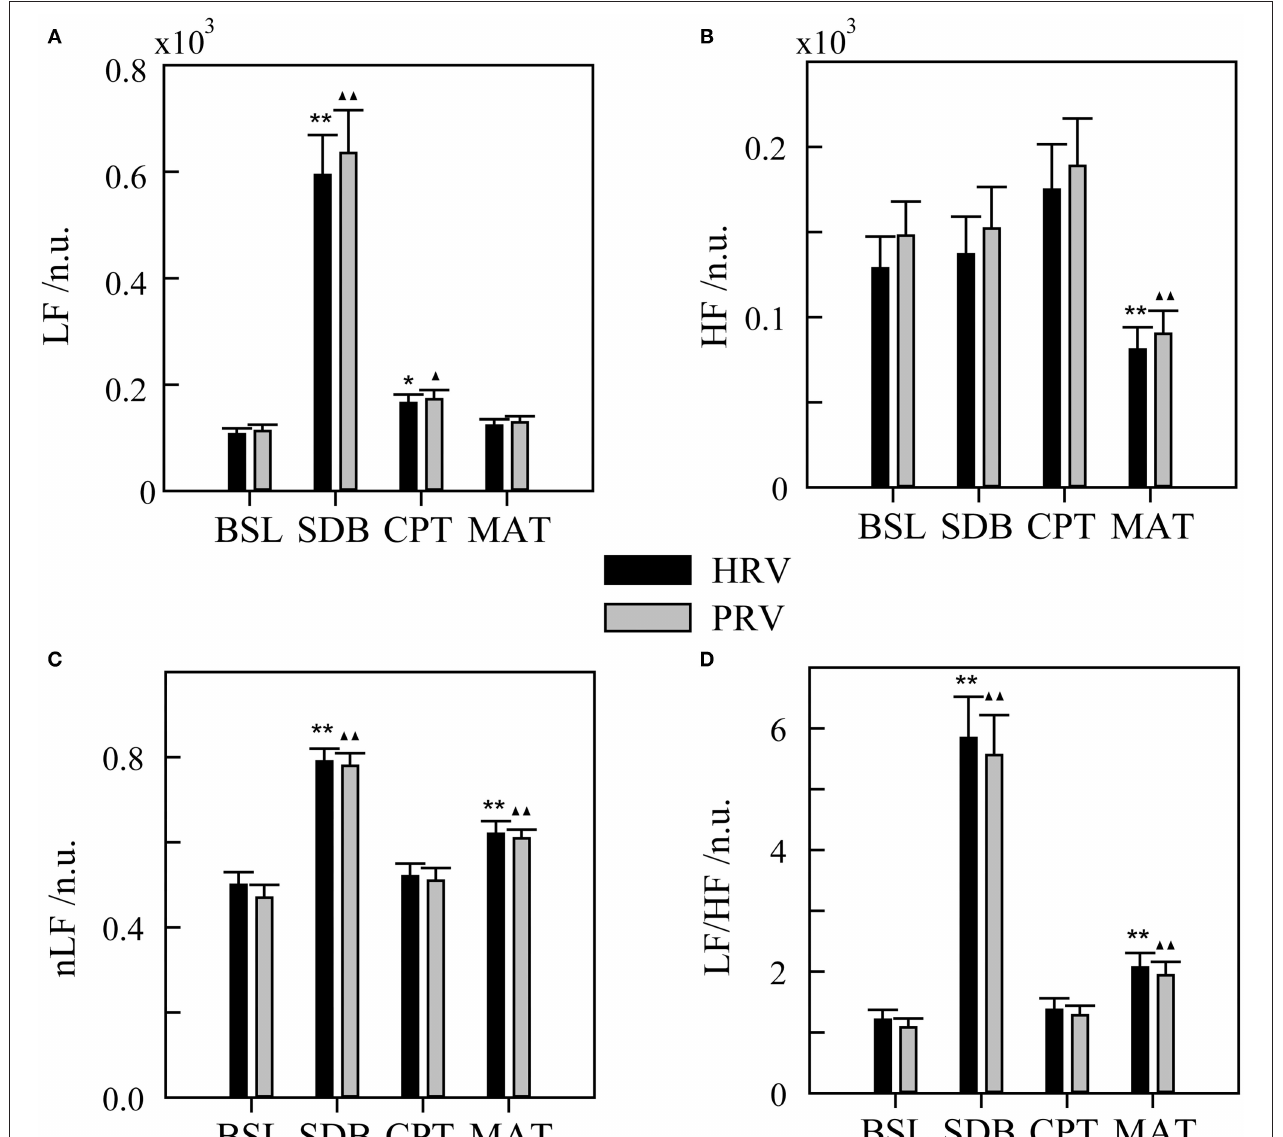
FIGURE 2 | Heart rate variability (HRV) and pulse rate variability (PRV) for different ANS activation patterns. (A) LF, low-frequency power. (B) HF, high-frequency power. (C) nLF, normalized low-frequency power. (D) LF/HF, ratio of LF to HF. BSL, baseline state; SDB, slow deep breathing; CPT, cold pressor test; MAT, mental arithmetic test. The significance of the differences in HRV parameters between each experimental state and BSL state is denoted by * for p < 0.05 and ** for p < 0.01. N and NN indicate p < 0.05 and p < 0.01, respectively, for the corresponding comparisons of the PRV parameters. The physiological mechanism of HRV parameters is considered as follows: LF mainly contains information on sympathetic activity, HF reflects parasympathetic activity, nLF is a relatively pure measure of sympathetic activity, and LF/HF reflects sympathovagal balance.